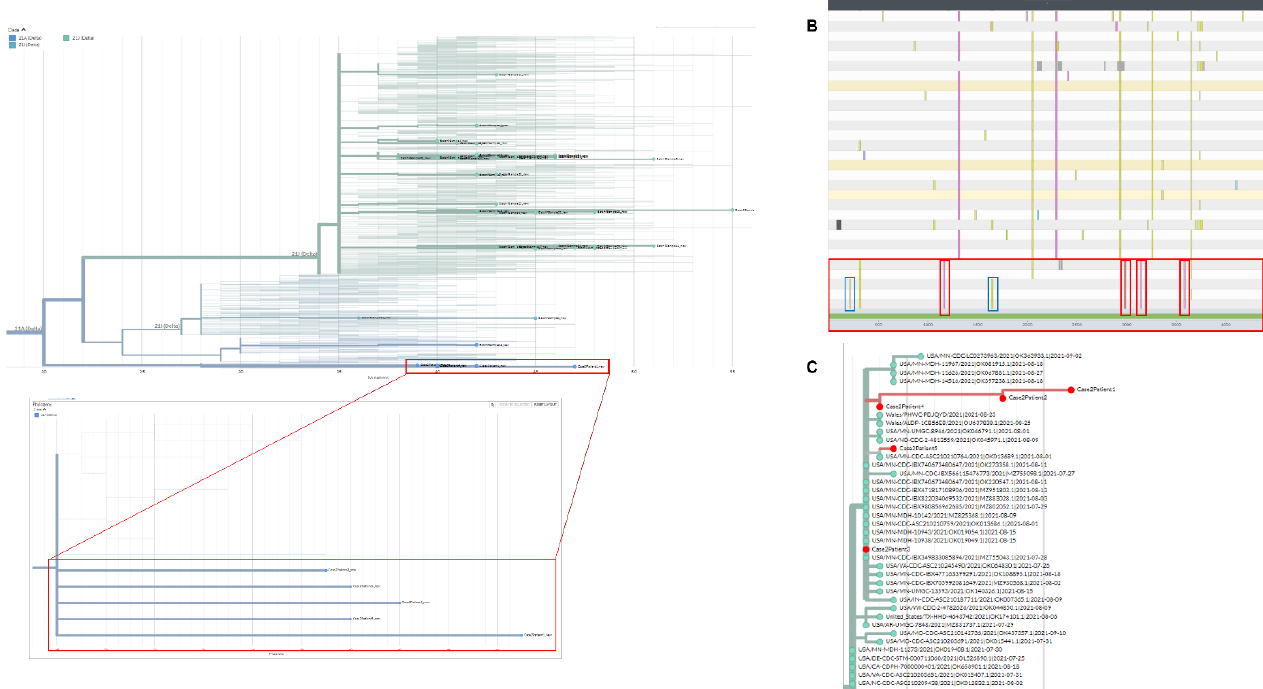
Figure 2. Phylogenetic and molecular analysis for outbreak case-2. ( A ) Nextclade phylogenetic clustering (cases highlighted by red boxes). ( B ) Nextclade gene viewer for CoV-2 ORF1a. Unique mutations are highlighted in red. ( C ) UShER analysis/clustering for outbreak samples with placement near most similar CoV-2 sequences.